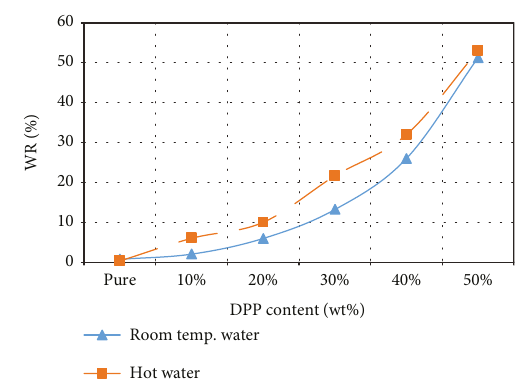
Figure 12: Water retention of DPP-polystyrene composites at 24hr